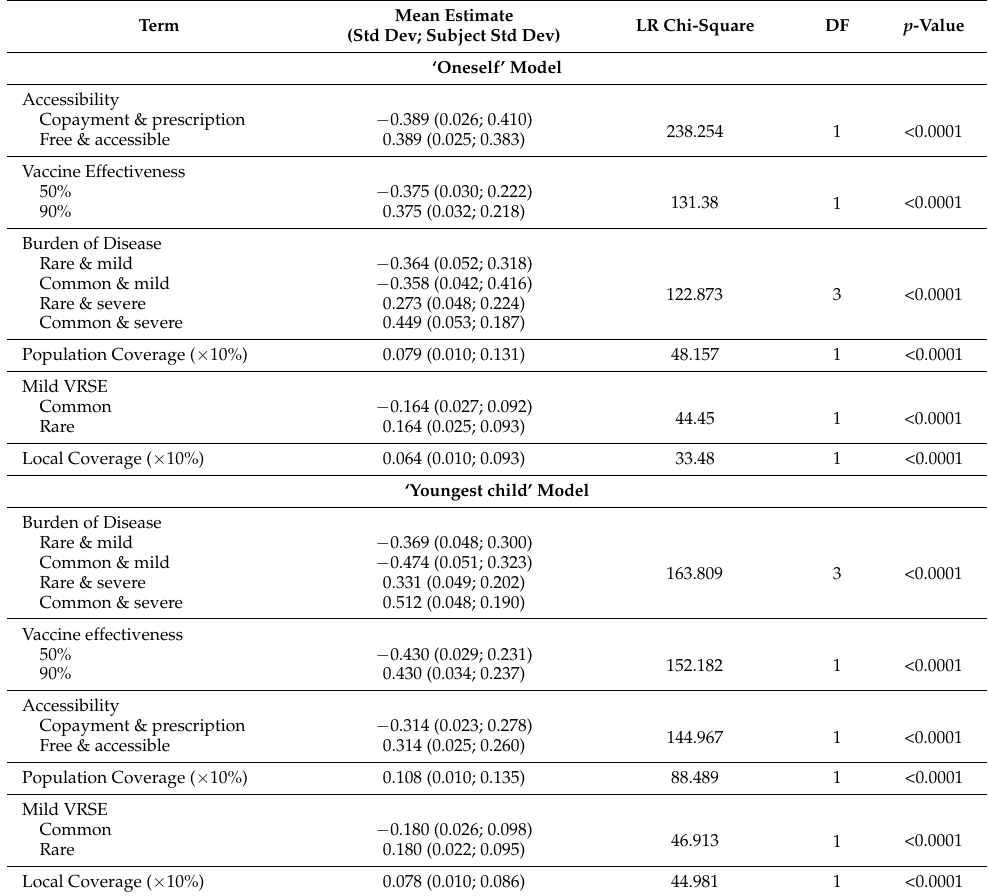
Table 5. Panel mixed logit model estimates (means and standard deviations) and significances of the attribute effects obtained from likelihood ratio (LR) tests.